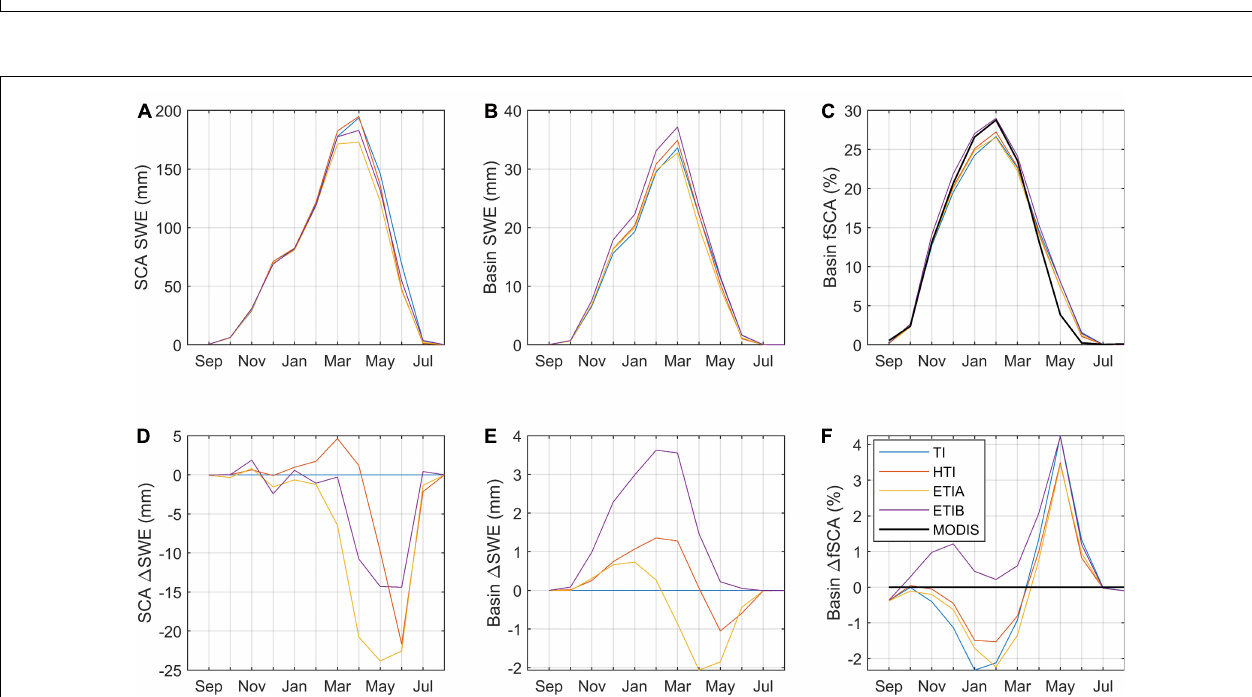
FIGURE 5 | Seasonal cycle of mean simulated snow water equivalent (SWE). (A) Over snow-covered area only. (B) Over the whole basin. (C) Mean simulated fSCA vs. MODIS. (D,E) Difference between radiative models and the reference TI model for panels A and B. (F) Difference between modeled and MODIS fSCA.